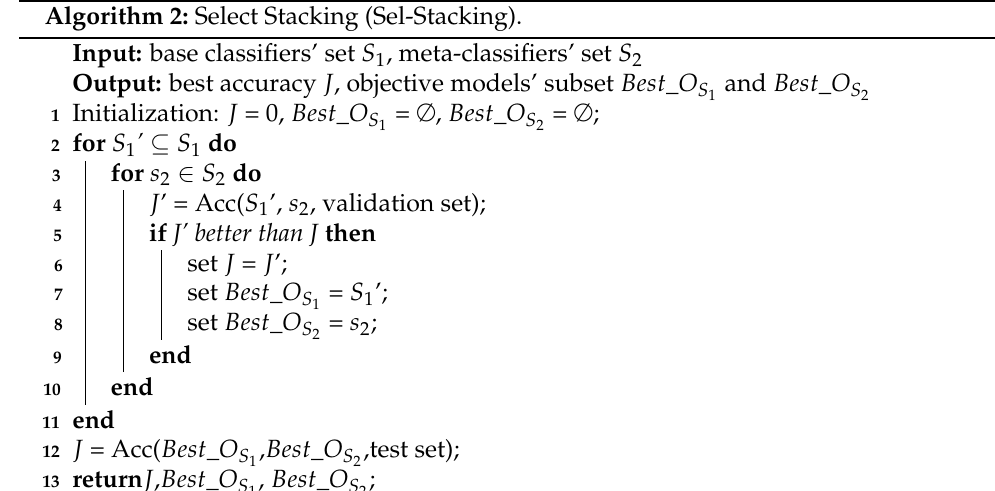
Algorithm 2: Select Stacking